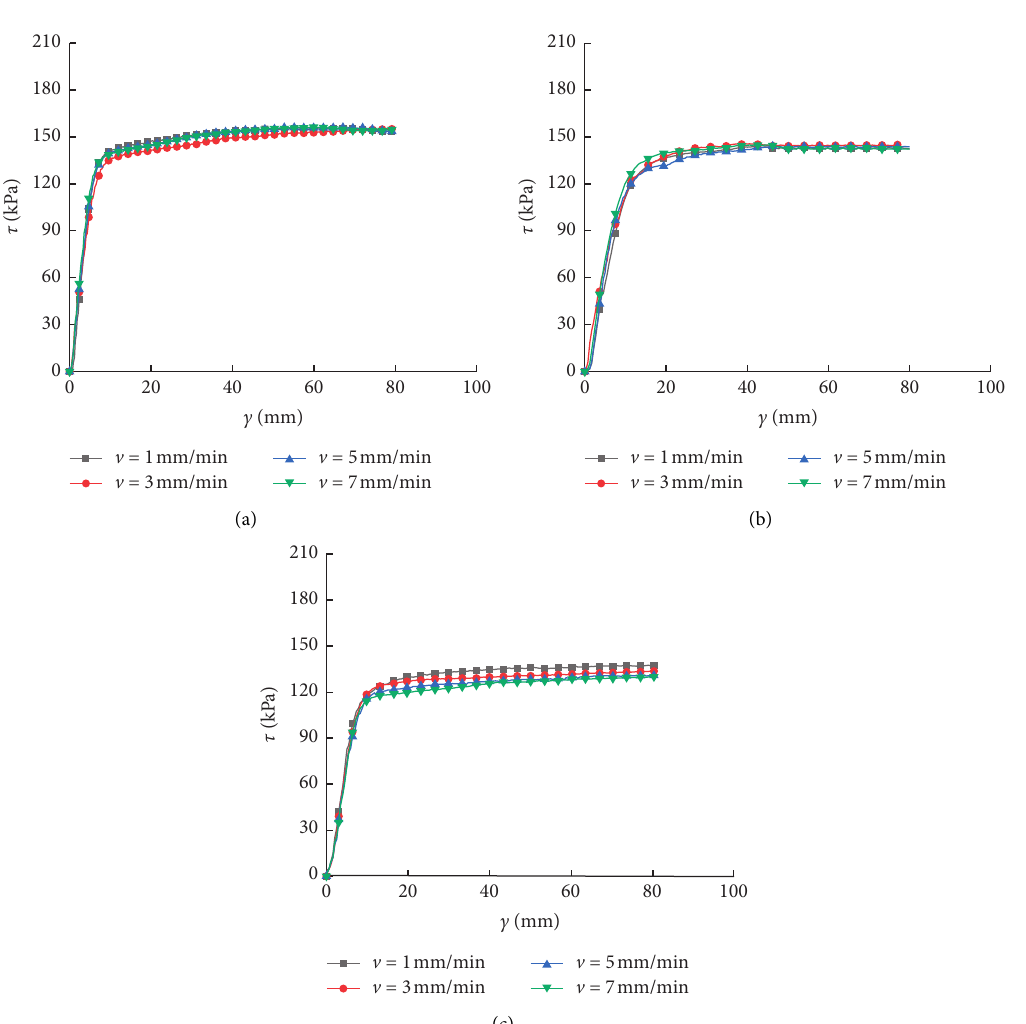
Figure 15: Shear stress-displacement curves of reinforced materials under different shear rates. (a) Reinforced soil with bamboo tendon grating. (b) Reinforced soil with the geogrid. (c) Plain